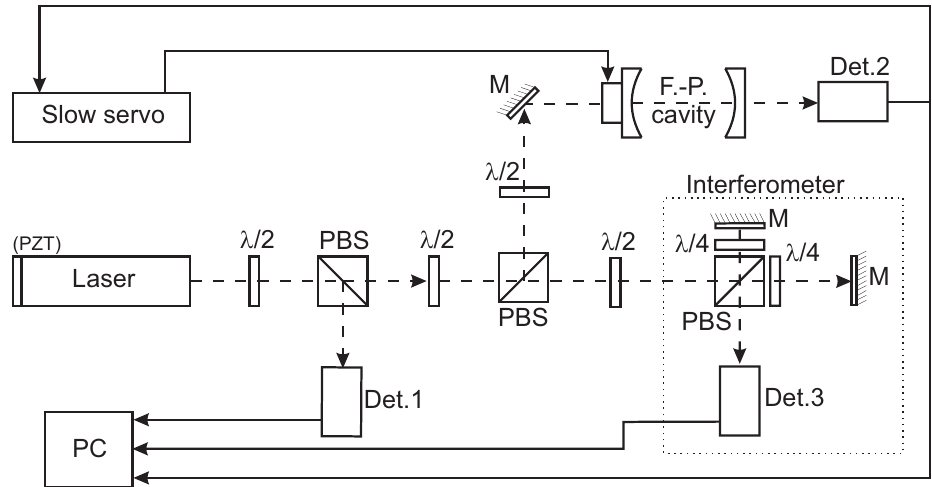
Figure 3. Schematic of the experimental setup for amplitude and frequency noise measurements. PBS-polarizing beam splitters, M-full reflective mirrors, Det-photodetectors (Det1 measuring amplitude noise, Det2 frequency noise throught the Fabry-Perot cavity,